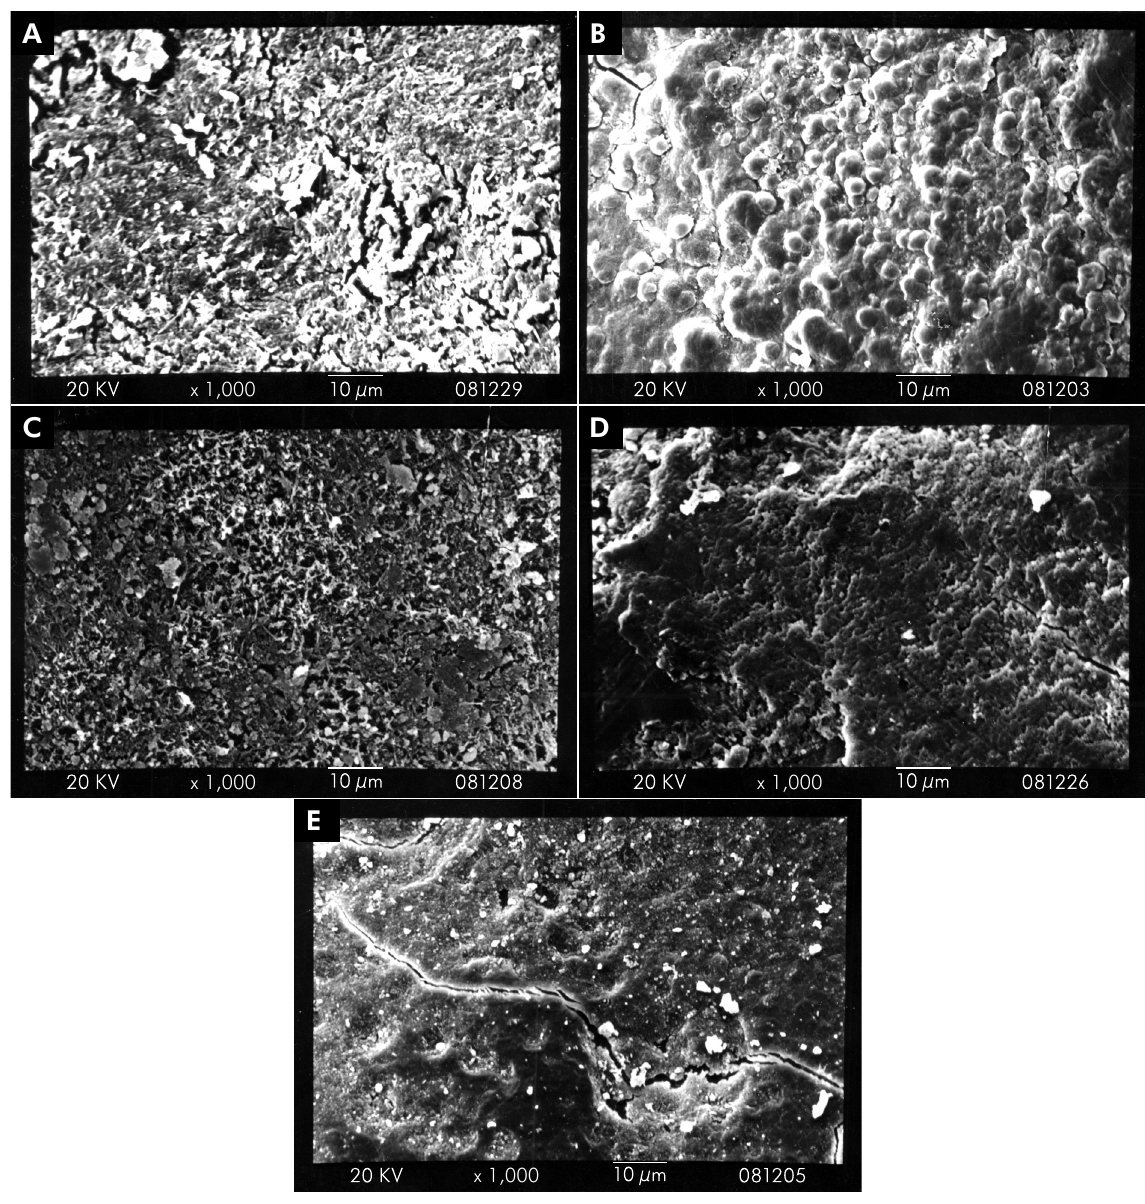
Figure 2. Representative scanning electron microscopy photomicrographs of the prevalent score for each experimental group. (A) At 0 (control), the root surface is completely covered by an amorphous smear layer; at (B) 7, (c) 14, and (D) 21 days, the root surface is partially covered by smear layer; (E) at 28 days, the root surface is not covered by an apparent smear layer and areas of resorption are observed. (Bar = 10 µm; original magnification,